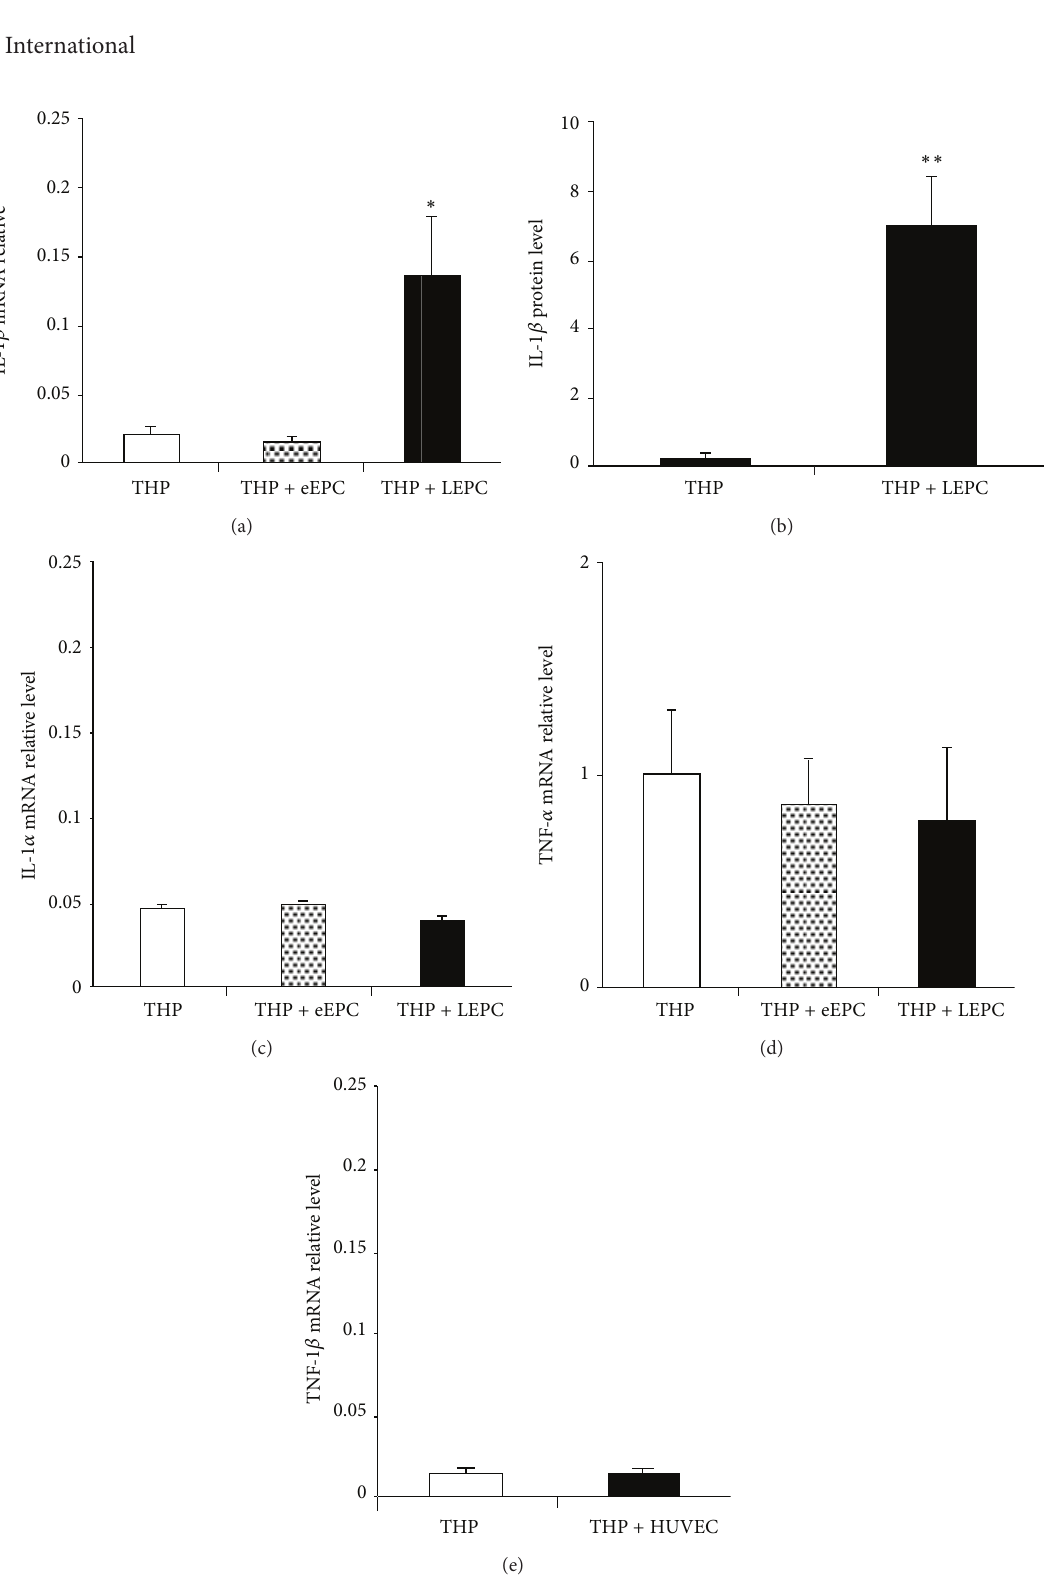
Figure 2: Late human EPCs upregulated IL-1 𝛽 expression in THP-1 monocytic cells. Coculture with late but not early EPCs led to a significant increase of IL-1 𝛽 mRNA levels in THP-1 cells as assayed by real-time RT-PCR with GAPDH as internal control (a). The conditioned medium (CM) from the late EPCs/THP-1 cell coculture system contained a significant higher level of IL-1 𝛽 protein as measured by a high sensitivity ELISA Kit (b). In contrast, neither early nor late EPCs affected IL-1 𝛼 (c) or TNF- 𝛼 expression (d). Coculture with terminally differentiated HUVECs did not result in changes of IL-1 𝛽 mRNA levels in THP-1 cells (e). ∗ 𝑃 < 0.01 ( 𝑛 = 5 ), ∗∗ 𝑃 < 0.005 ( 𝑛 = 5 ), both compared to THP-1 cells cultured alone. eEPC: early EPC; LEPC: late